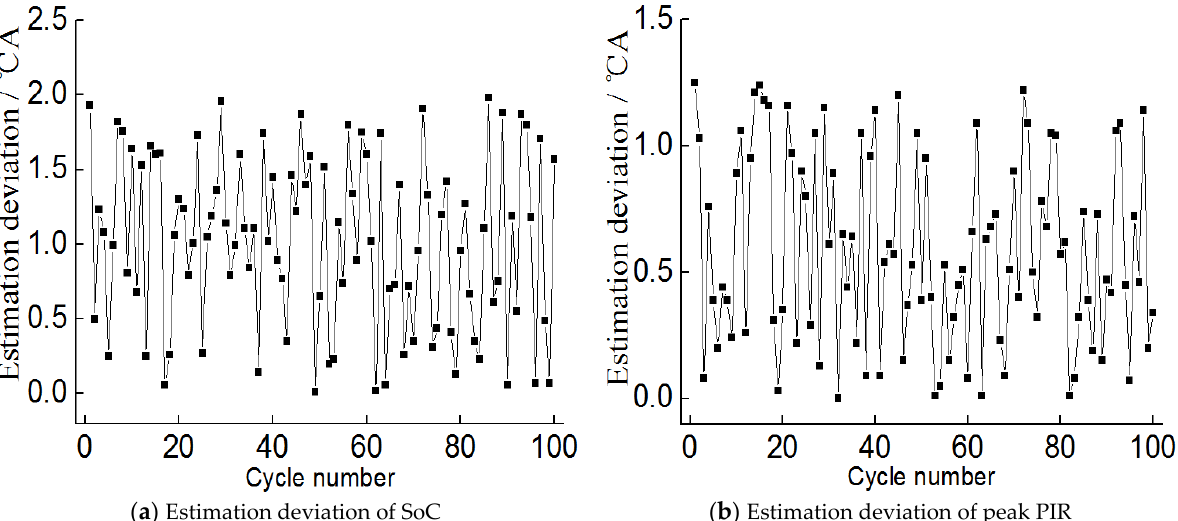
Figure 17. The estimation of SoC and peak PIR at the engine speed of 1500 rpm and the power of 450 kW.